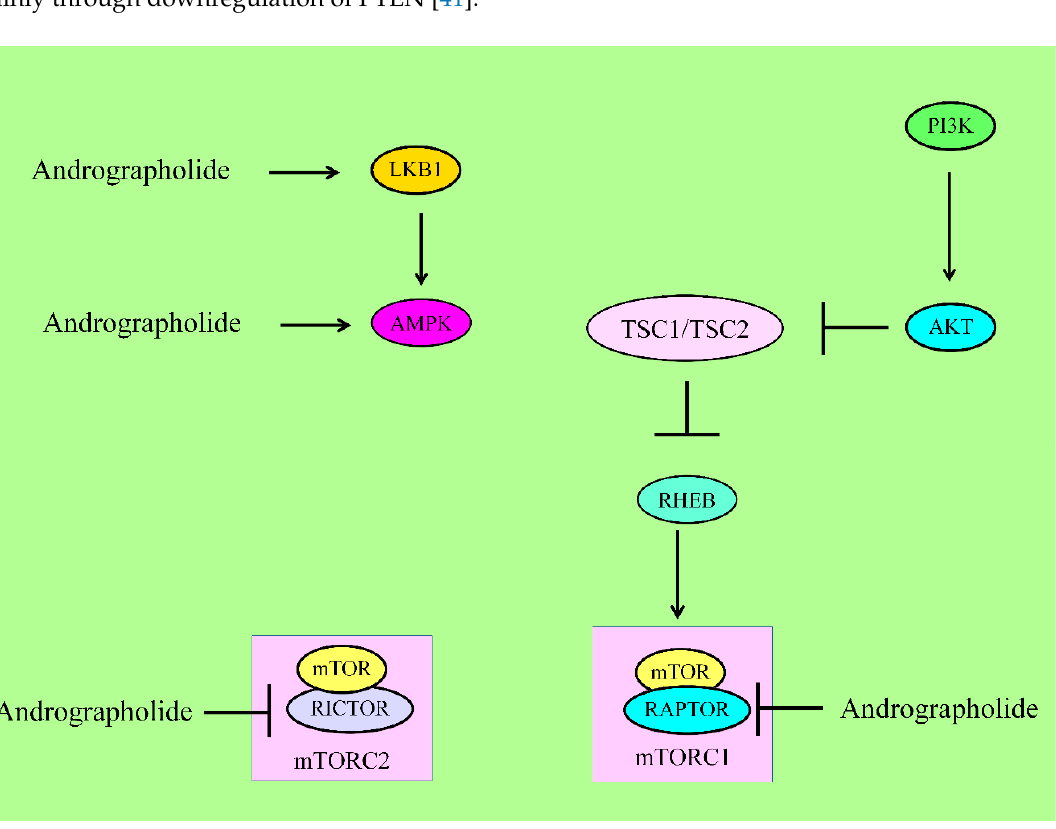
Figure 3. For activation of mTORC1, PIP3 recruited PDK1 to activate AKT. AKT inhibited the TSC complex, which acted as GTPase-activating protein (GAP) on the GTPase RHEB. GTP-bound RHEB structurally associated and activated mTORC1. Energy stress activated LKB1 and AMPK to suppress mTORC1 via inhibition of RAPTOR and activation of the TSC complex1. Andrographolide inhibited RAPTOR (mTORC1) and RICTOR (mTORC2). mTOR has different domains. RAPTOR and RICTOR bind to HEAT repeats of mTOR. Phosphoinositide-dependent kinase 1 (PDK1), liver kinase B1 (LKB1), AMP-activated kinase (AMPK), regulatory-associated protein of mTOR (RAPTOR).